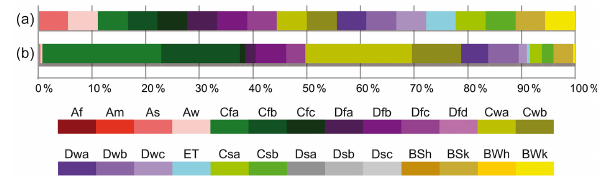
Figure 3. Köppen signal for genus Tilia extracted from 26 ex- tant species. (a) Köppen–Geiger climates in which Tilia is present. (b) Combined Köppen signature of all 26 extant Tilia species. Dia- grams based on extracted data from Supplement